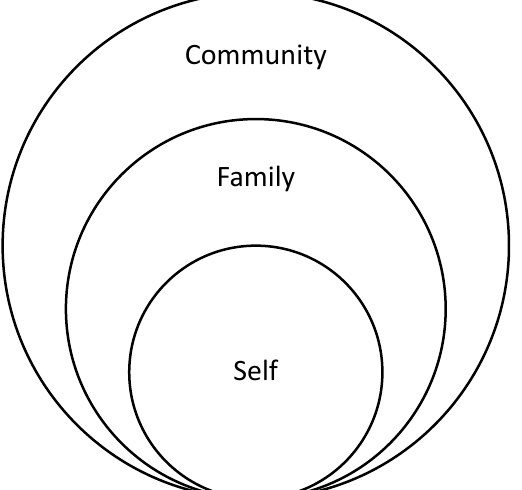
Figure 4. The outcome space – a visual representation of categories of description and their interrelationship. From The Ability to Access Post-Secondary Education: Adult Learners’ Conceptions of Choosing Online Learning (p. 116), by K. Rasmussen, 2015, Lancaster University, UK. Copyright 2015 by Kari